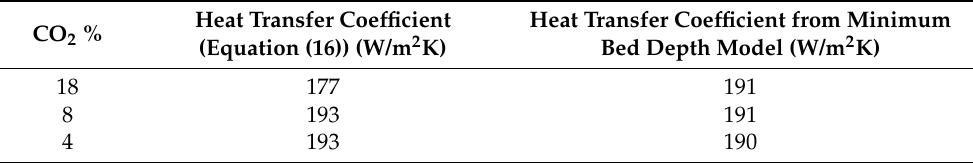
Table 8. Comparison of different methods for calculation of heat transfer